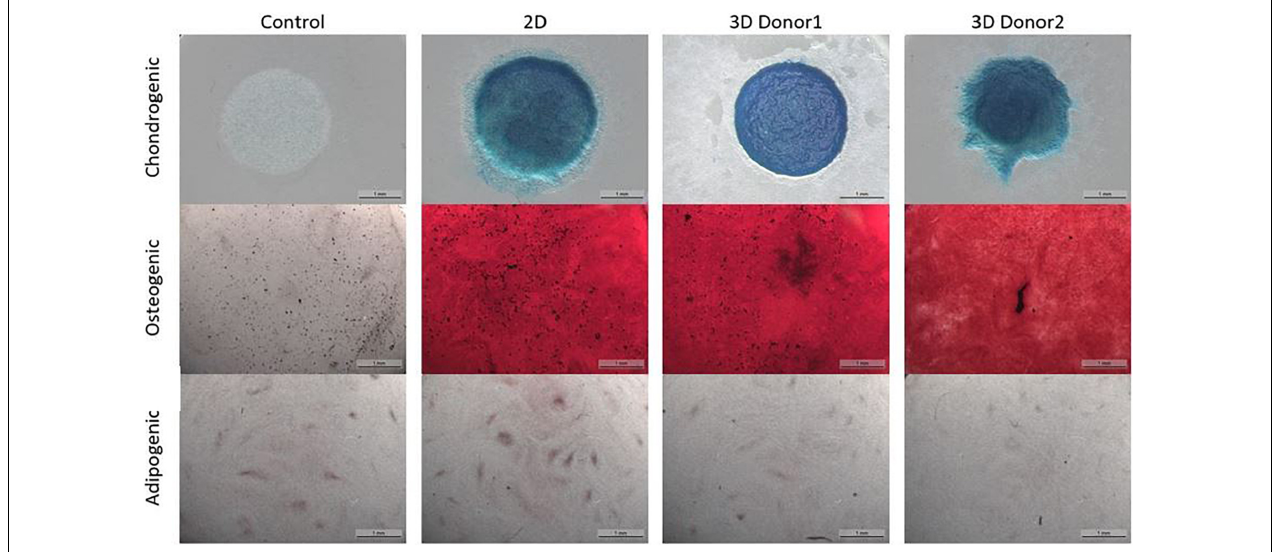
FIGURE 11 | Trilineage differentiation of the dynamic Star-Plus evaluation for a control sample without differentiation medium, a 2D sample from cells cultured in tissue flasks and 3D samples from cells of two different donors cultured in spinner flasks on Star-Plus microcarriers.